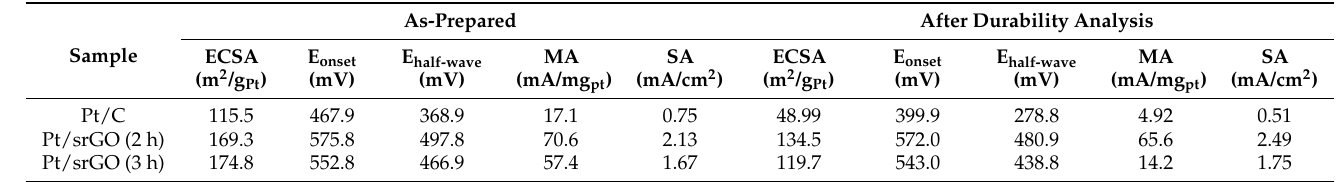
Table 4. ECSA, E onset , E half-wave , MA and SA change of the catalysts during durability analysis.